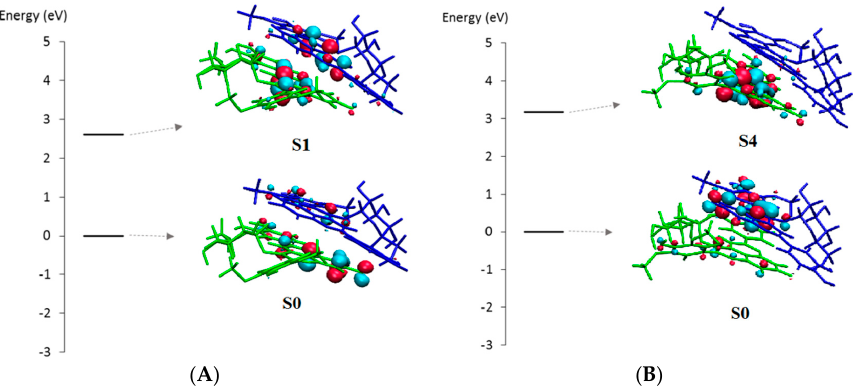
Figure 14. Molecular orbital description of the A···A PA1 dimer: ( A ) Geometry 1 exhibiting slight CT in the first excited state (S0 → S1); and ( B ) Geometry 4 exhibiting strong CT in the fourth excited state (S0 → S4).